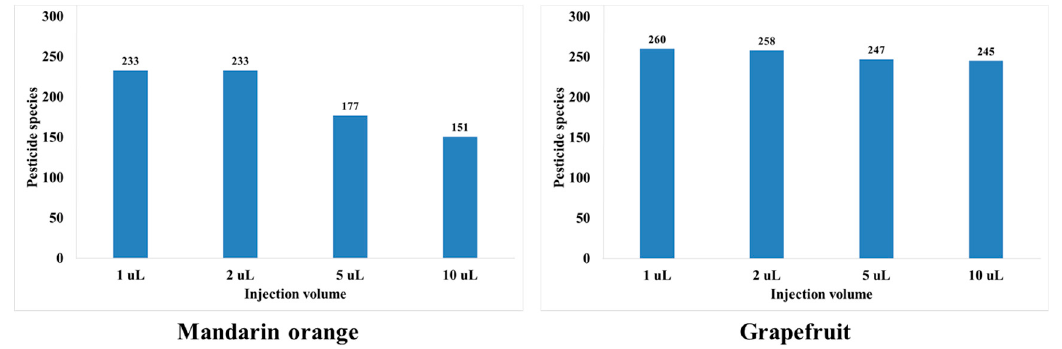
Figure 3. Number of pesticides showing soft matrix effect ranging from − 20 to 20% depending on injection volume.